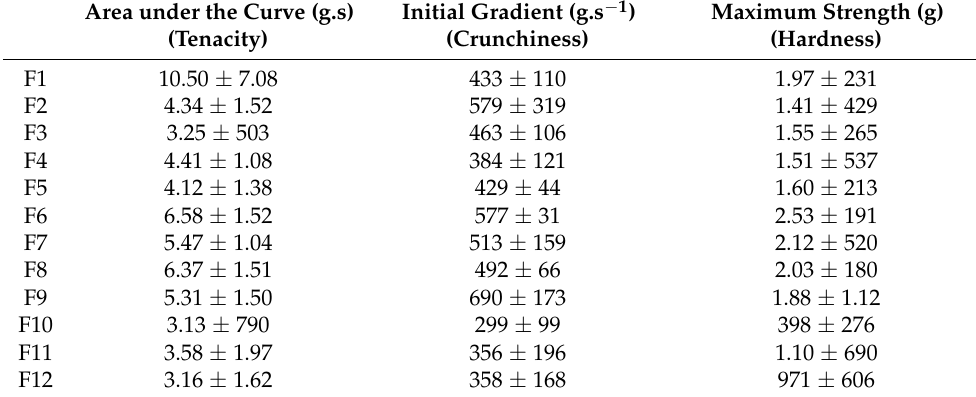
Table 4. Texture analysis of the designed formulations after thermal treatment. Area under the Curve (g.s)